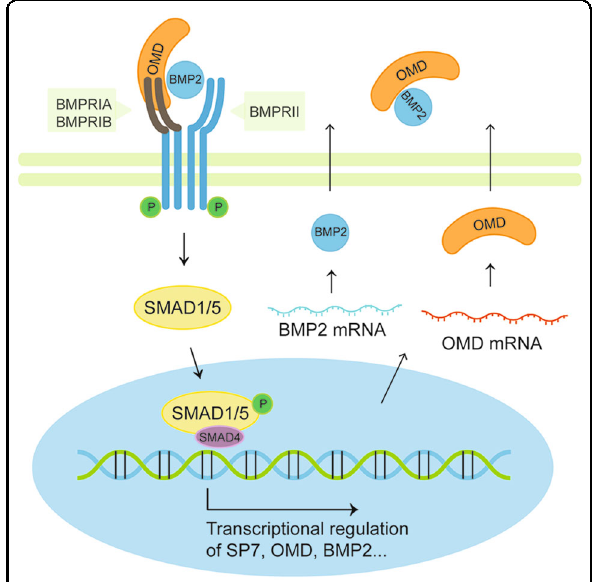
Fig. 5 Schematic representation of the mechanism by which OMD mediates osteogenesis and acts as a coordinator of BMP2/ SMAD pathway. During the process of osteogenic differentiation, the expression of OMD is elevated in hDPSCs. The mature OMD protein interacts with BMP2 cytokine via its C-terminal leucine-rich repeats and clusters with BMP receptors, which may facilitate BMP2 to anchor its cell surface receptors and further ignite intracellular signal transmission. The nuclear translocation of phosphorylated SMAD1/5 activates the transcription of osteogenic-associated genes such as SP7 , OMD and BMP2 , and consequently exert biological